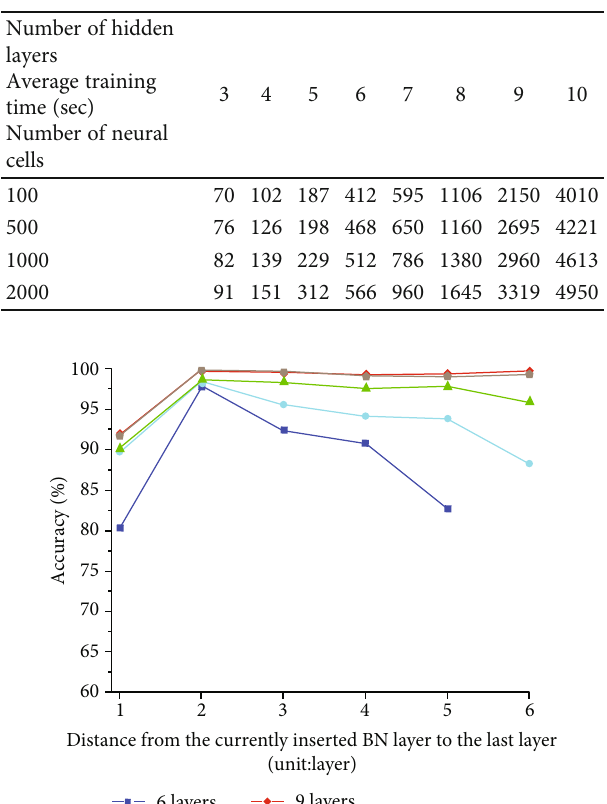
Table 10: The training time using di ff erent numbers of hidden layers and neural cells.